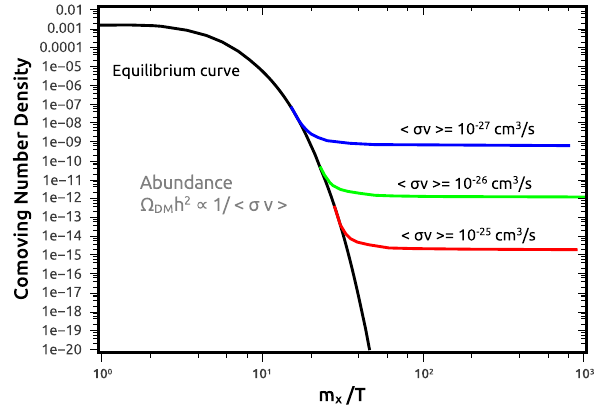
Fig. 2 Comoving number density evolution as a function of the ratio m χ / T in the context of the thermal freeze-out. Notice that the size of the annihilation cross-section determines the DM abundance since Ω 2 ∝ 1 / (cid:2) σv DM h